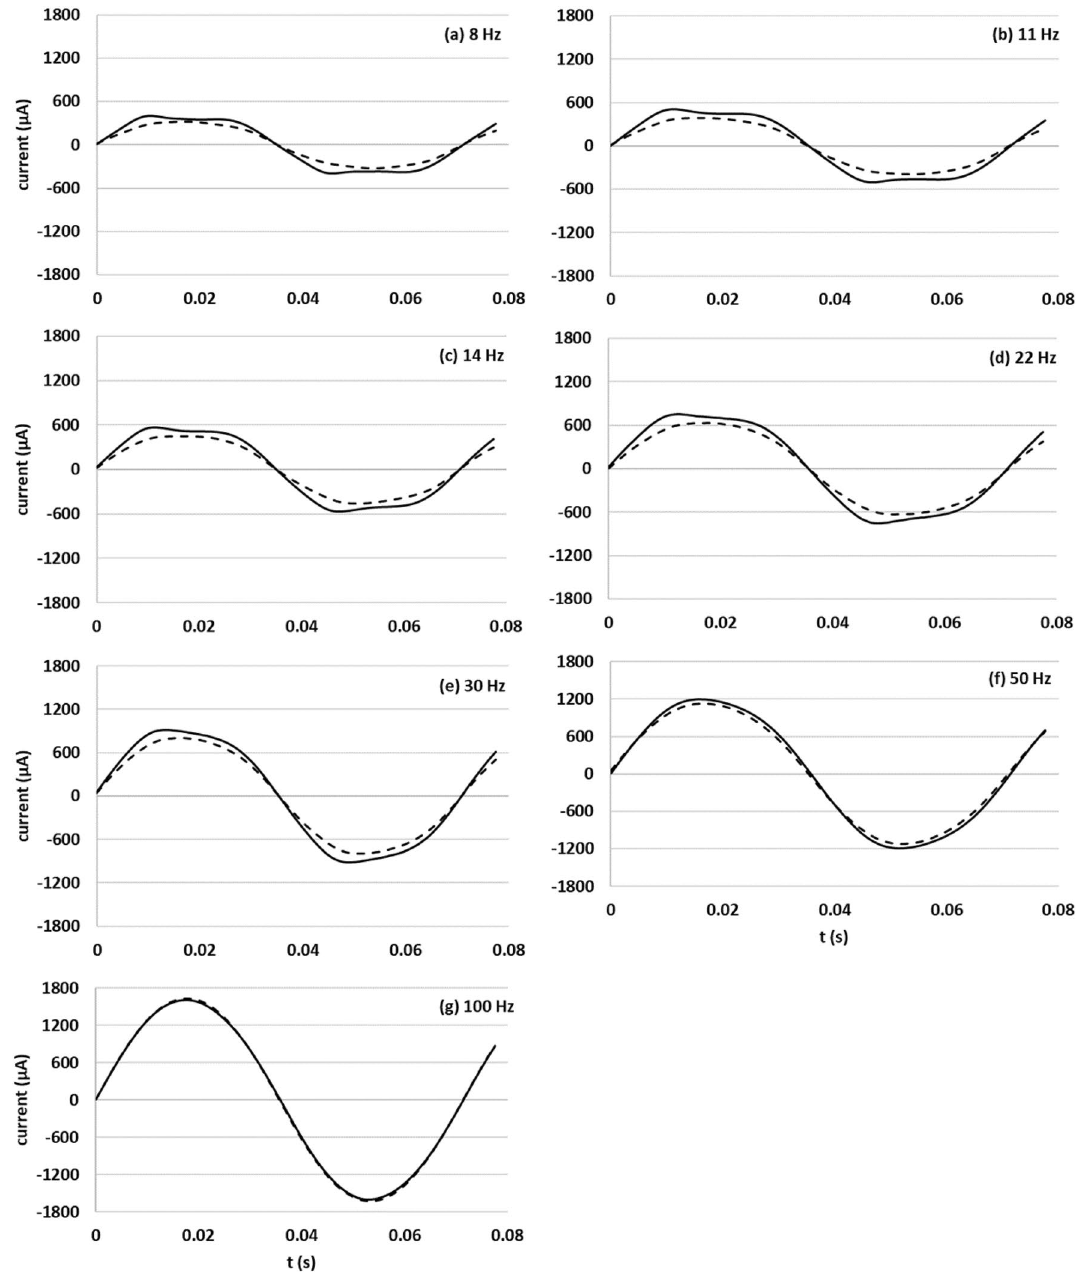
Figure 2. ( a )–( g ) Current waveforms of living and dead yeast 90 s after measurement was initiated at frequencies of 8, 11, 14, 22, 30, 50, and 100 Hz at 1.2